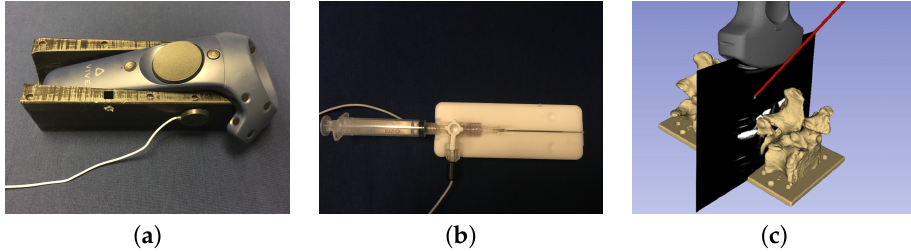
Figure 3. ( a )The co-calibration apparatus tracked by the VIVE controller and magnetic pose sensor; ( b ) the calibration apparatus for the syringe; and ( c ) visual representation of an example of tracked tools registered in the HMD’s coordinate system, where the alignment between the models of the spine and needle and their reflections in the US image indicated the total system